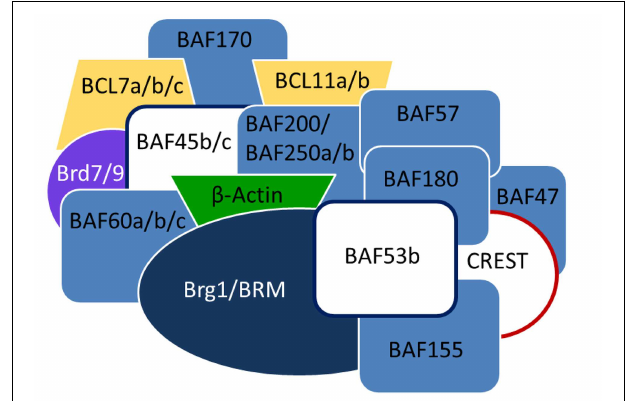
FIGURE 1 | Proposed model of the nBAF complex. Subunits in white are subunits thought to be neuron-specific. Adapted from Staahl and Crabtree (2013)